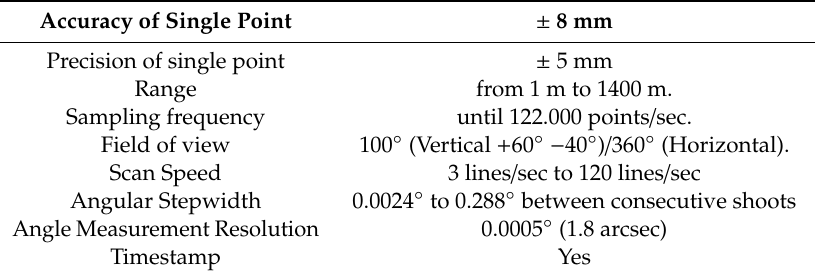
Table 1. Characteristics of TLS Riegl VZ-1000 ®